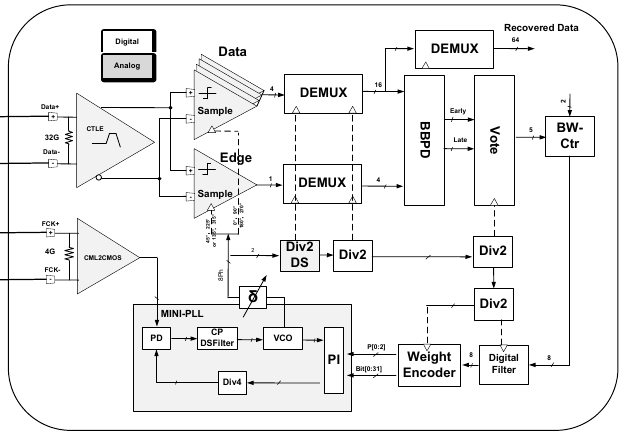
Figure 3. Integral structure of